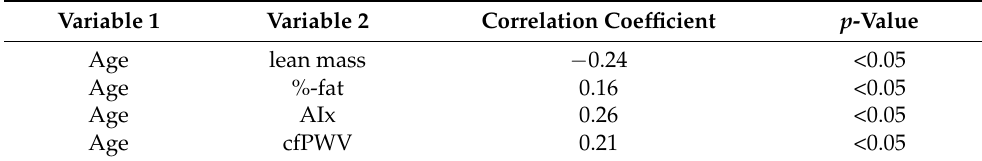
Table 1. Correlation between age, body composition, and arterial stiffness.